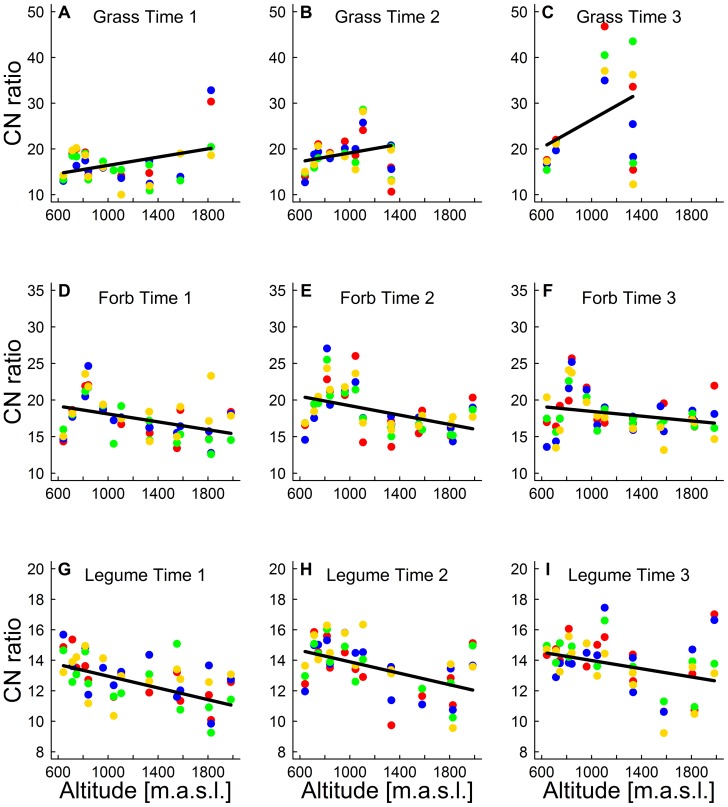
Effects of altitude, treatment and their interaction on CN ratio of three plant guilds (grasses, legumes, forbs) at three sampling times (A–I).CN data are presented as mean values per study site and treatment. Points symbolise the study sites and different colours represent the four treatments (blue: advanced snowmelt, green: delayed snowmelt, yellow: extreme drought, red: control). Black lines are based on the simplified model and show different slopes for CN ratio with altitude. Statistics see Table 1.